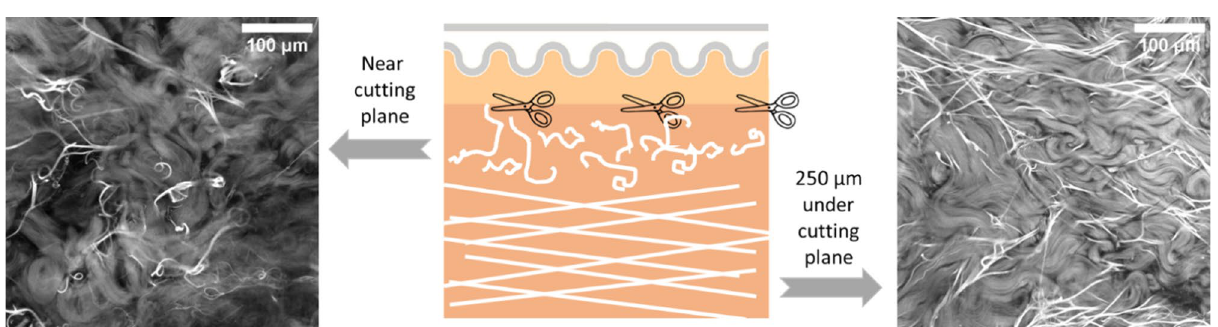
Figure 8. In-plane sections of optically-clarified tissue, near the cutting plane and 250 µm under the cutting plane, images obtained on the 2PEF channel of the multiphoton microscope. The elastic fibers appear with a strong fluorescence signal, the background signal is the collagen auto-fluorescence